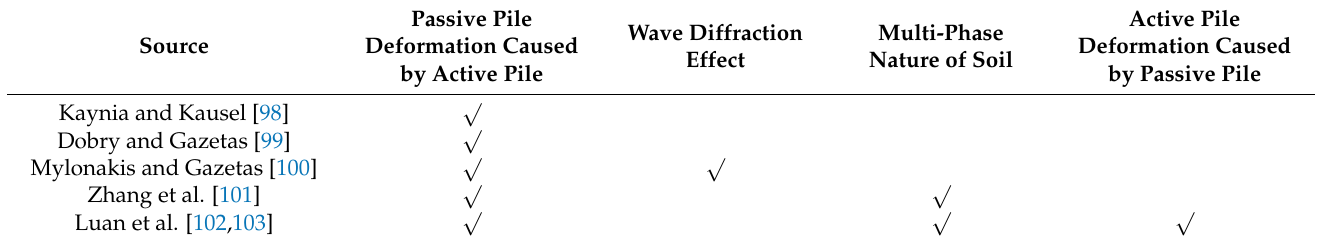
Table 1. Comparison of the referred ‘dynamic interaction factor α v ’ for consideration of pile group